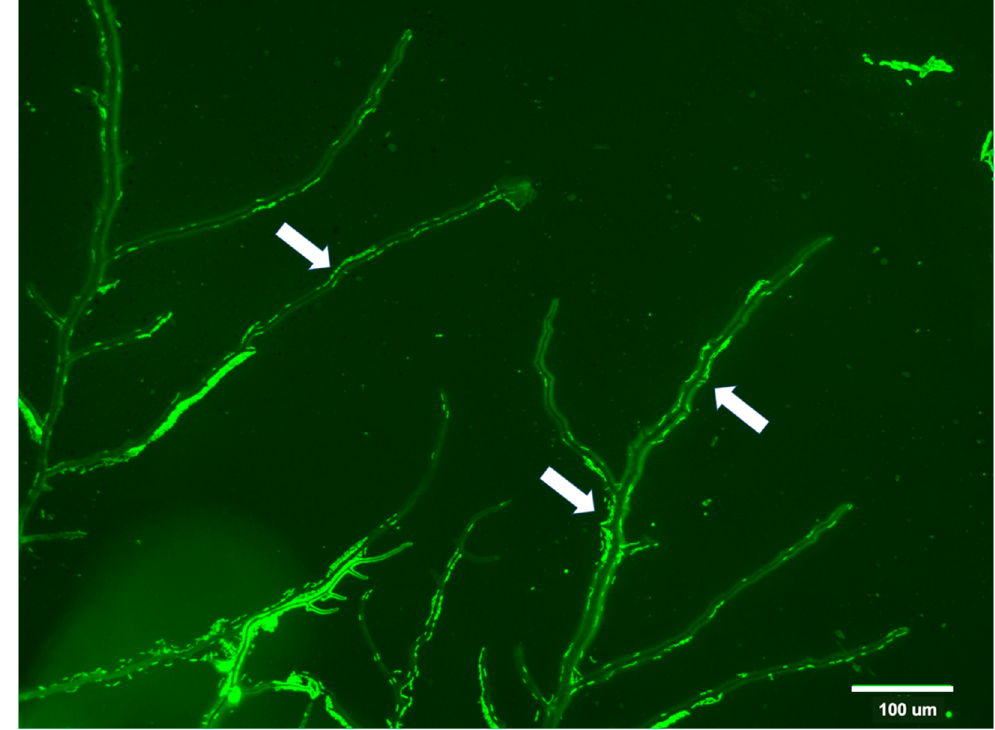
Figure 4. Optical microscopy photograph (magnification: 400 × ) showing the association of green- stained bacterial cells in the liquid layer from hyphae of the fungus contained in the commercial compost and grown on agar plate. Bacterial cells on hyphae are indicated by arrows and they can also be visualized a video in the Supplementary Video S1.